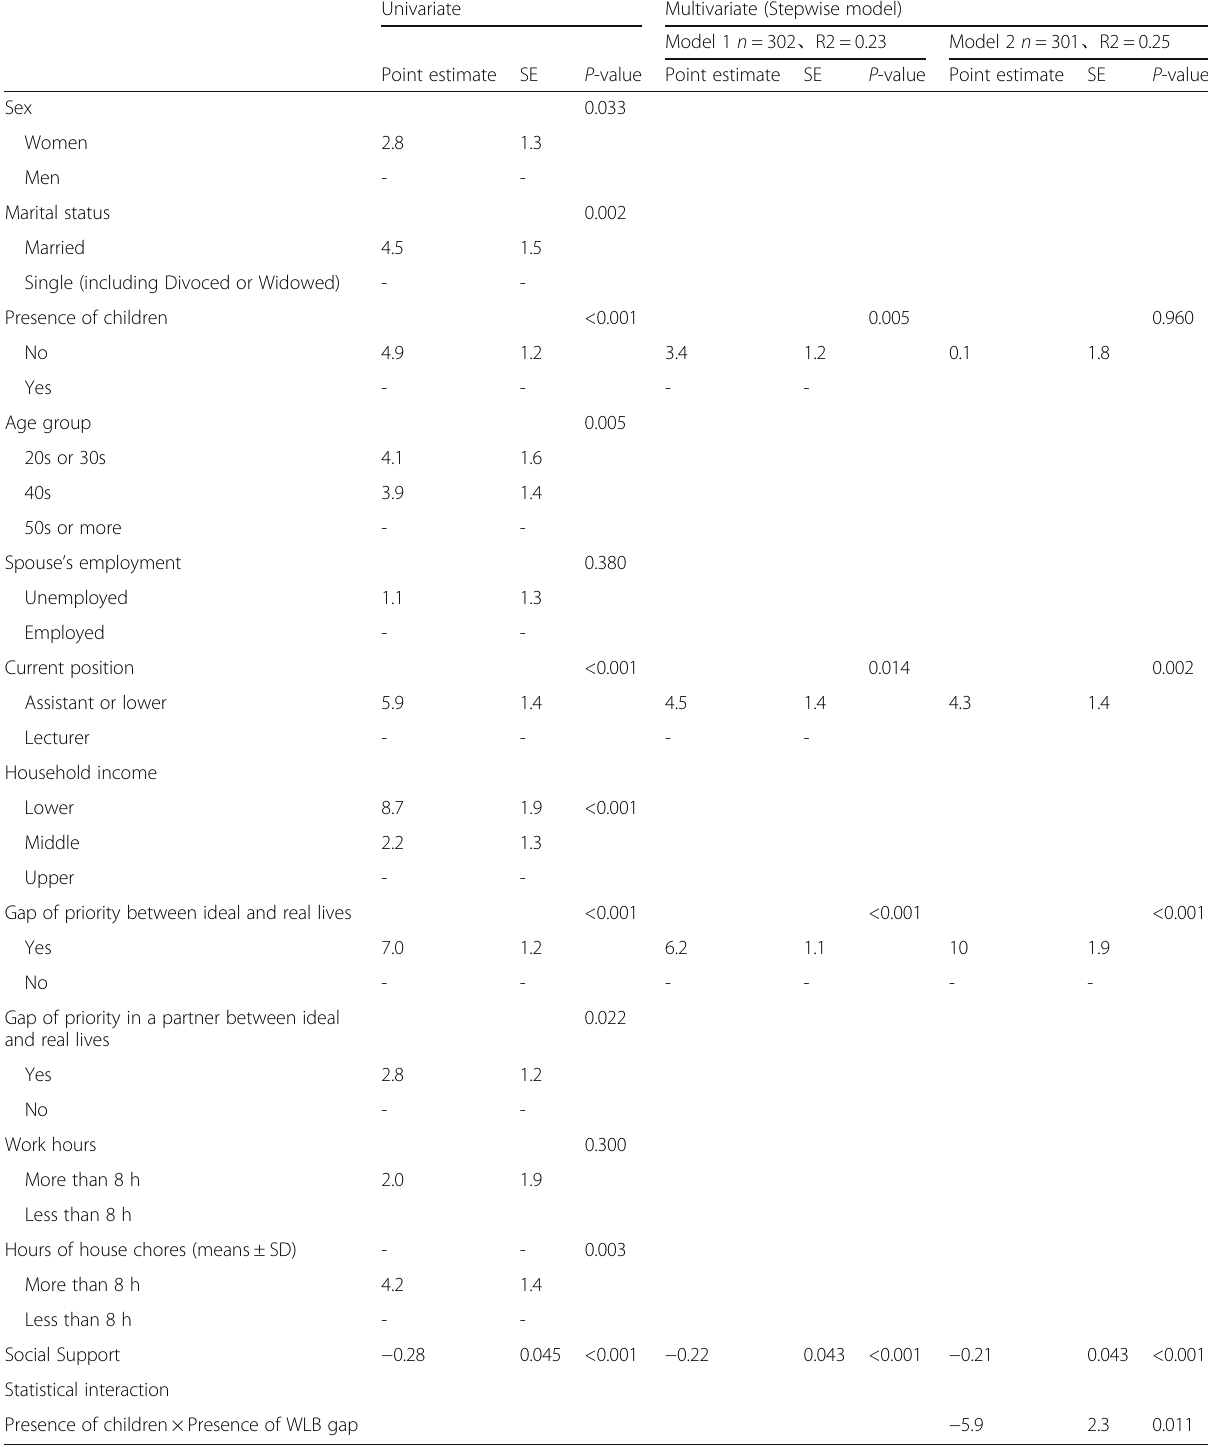
Table 3 General linear models of an effect of covariates on burnout, both univariate and multivariate models Univariate Multivariate (Stepwise